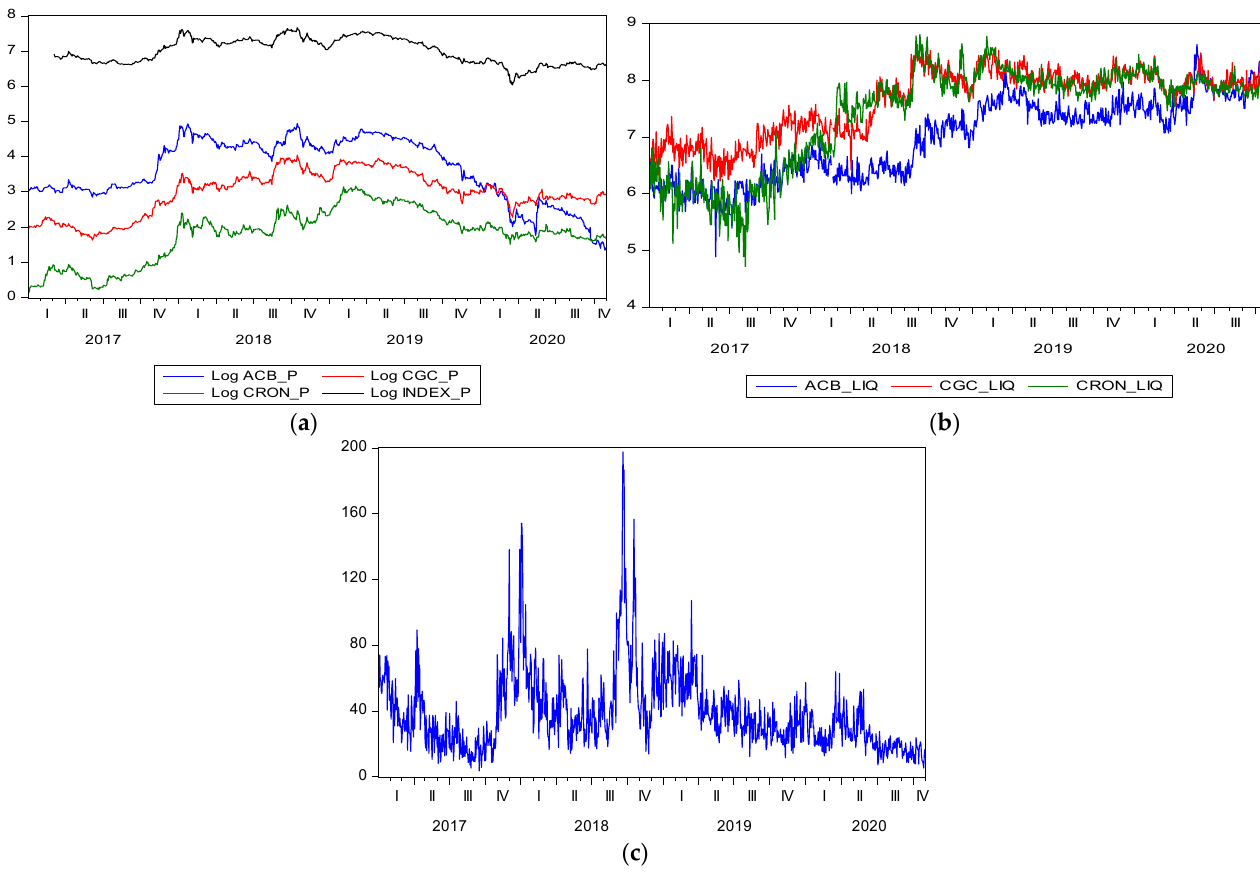
Figure 1. This figure presents the employed variables. ( a ) Stock and index historical prices (in logs); ( b ) liquidity measure; ( c ) Google Trends indicator regarding cannabis stock hits.